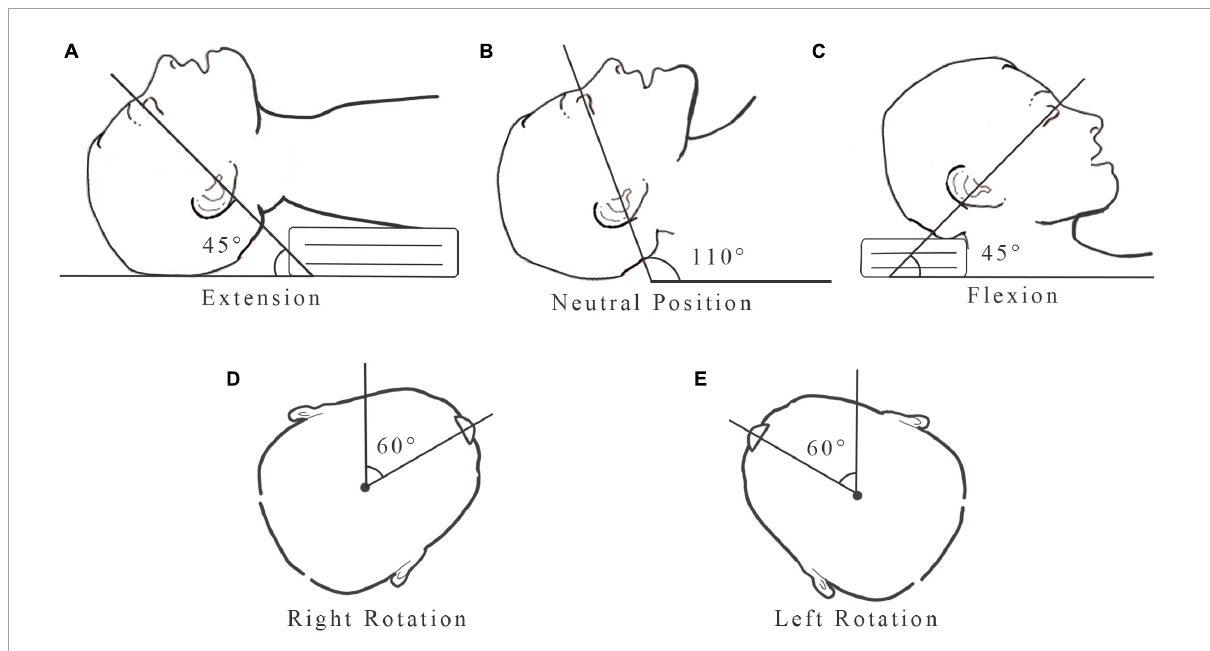
FIGURE3 Head position: (A) 45 ◦ extension; (B) neutral position; (C) 45 ◦ flexion; (D) 60 ◦ right rotation; (E) 60 ◦ left rotation.